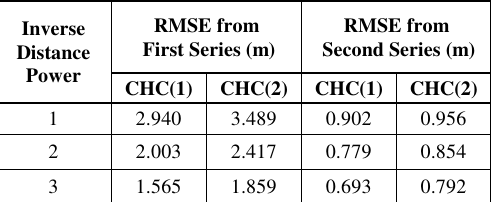
Table 4: Results Obtained from IDW